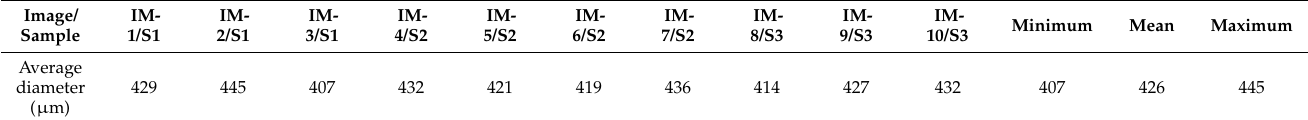
Table 2. Parameters determined for individual images obtained using the confocal